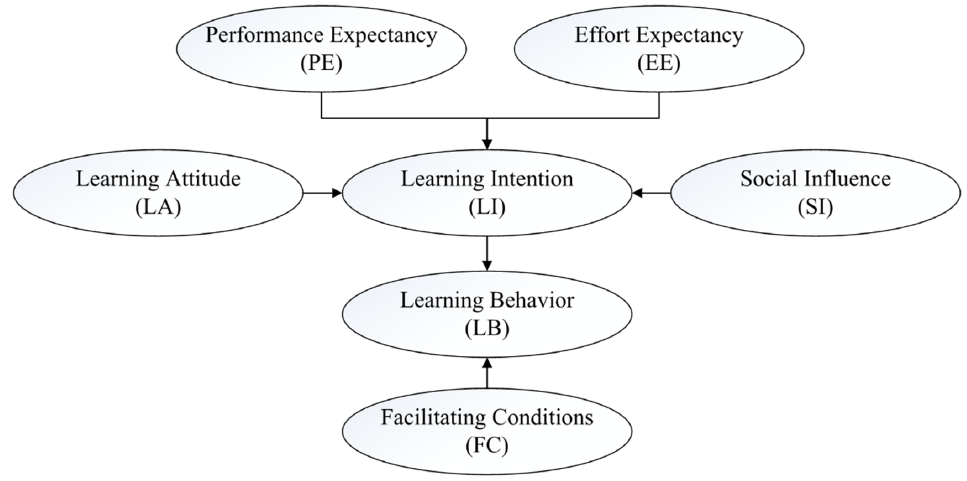
Figure 1. Theoretical framework model of BIM learning behavior research.